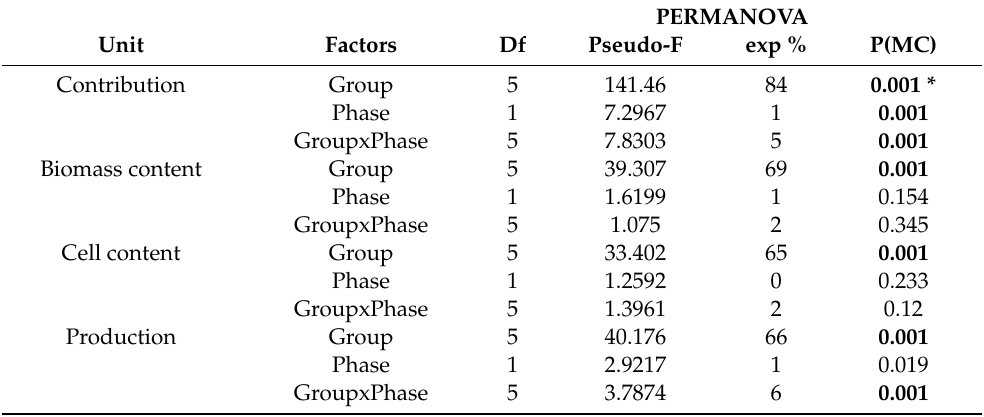
Table 2. Pseudo-F and Monte Carlo p-values (P(MC) for PERMANOVA analysis of ω -3 and ω -6 PUFA of phytoplankton strains by the phytoplankton group and phase and mix of them as